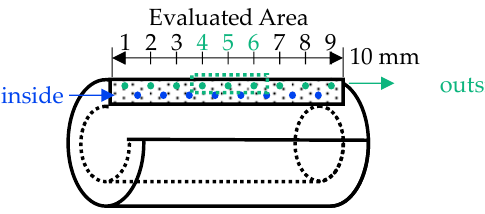
Figure 5. Measuring points for all presented hardness data.